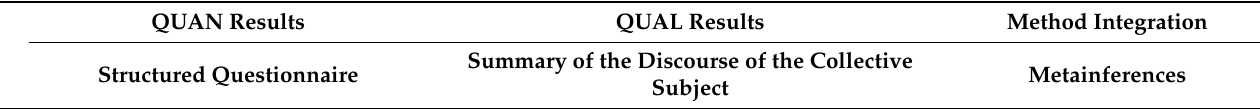
Table 3. Joint display of quantitative and qualitative inferences summarized in the DCS, and meta- inferences based on the items of the sensor prototype evaluation. Coimbra, Portugal,